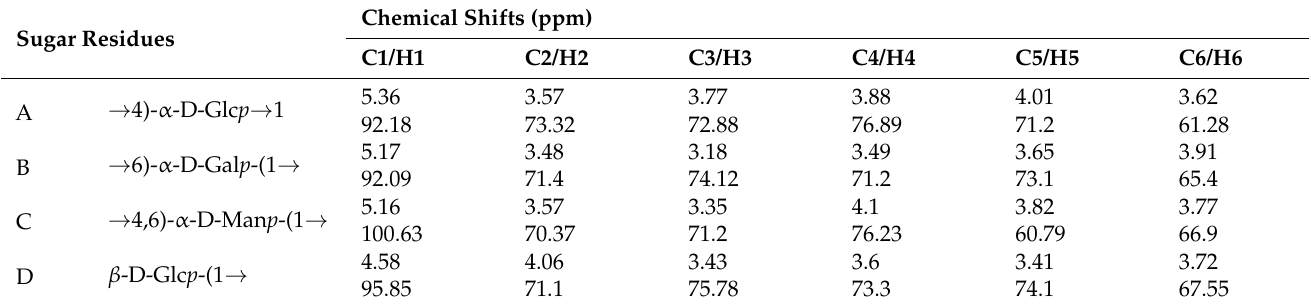
Table 2. 1 H and 13 C chemical shifts from identified 2D NMR spectra of SGP-1-1.